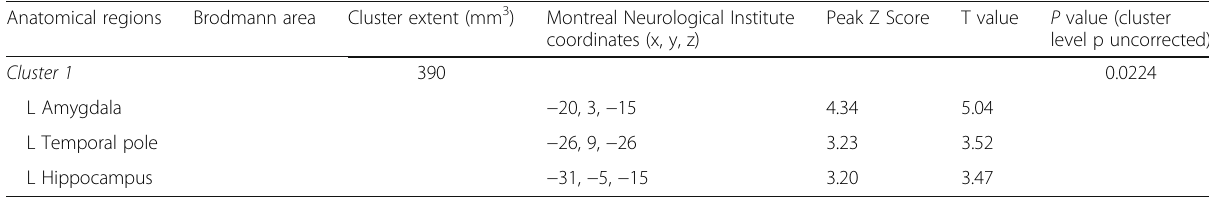
Table 2 Clusters of significant gray matter reduction in patients with chronic migraine vs. healthy controls using uncorrected maps at p <